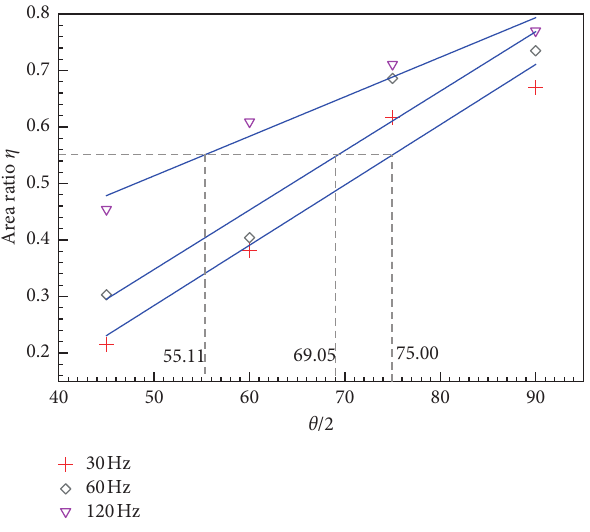
Figure 12: Fitting curve of θ and η. Table 12: Correlation analysis of θ and η.